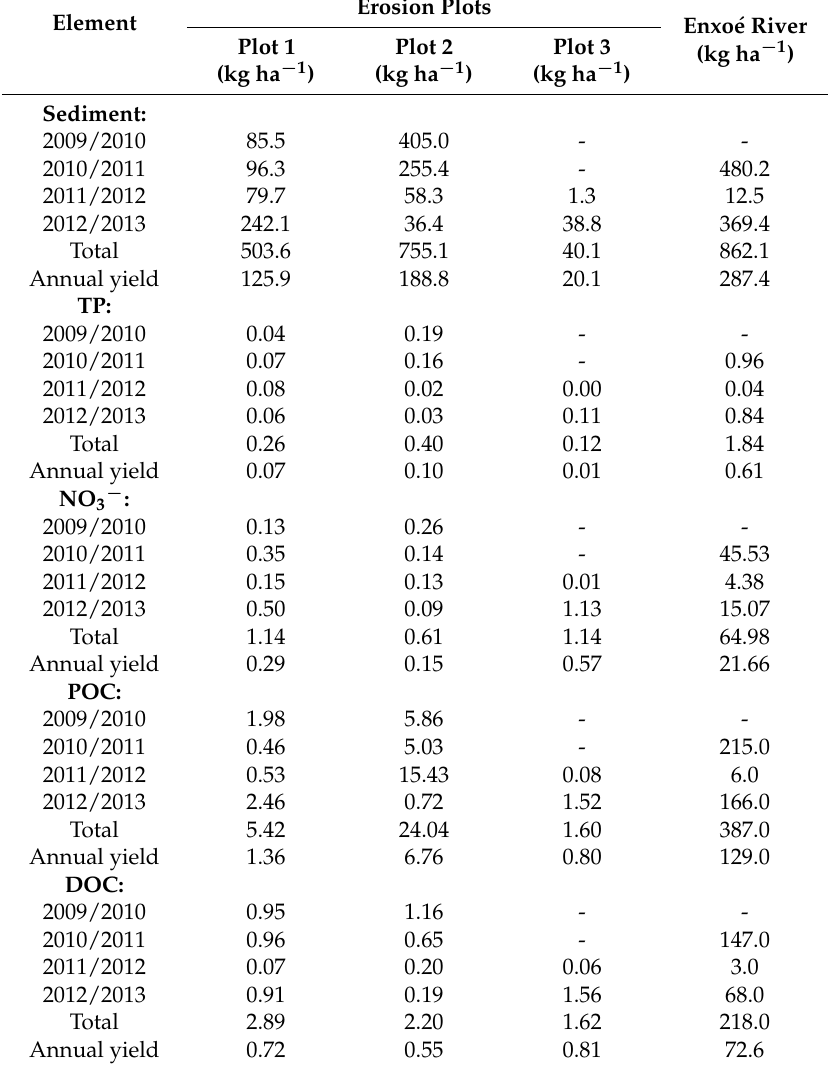
Table 1. Soil and nutrient yields in the Enxo é